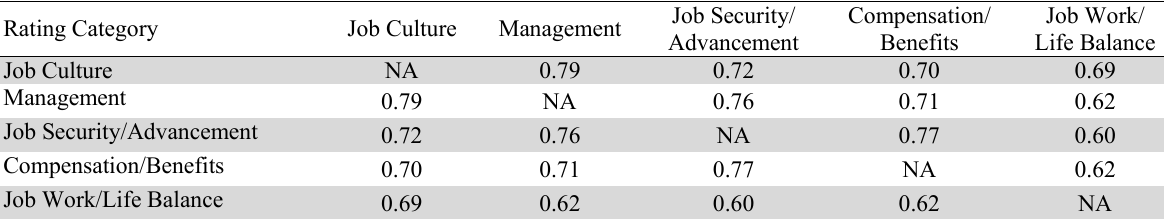
Correlation Among Rating Categories